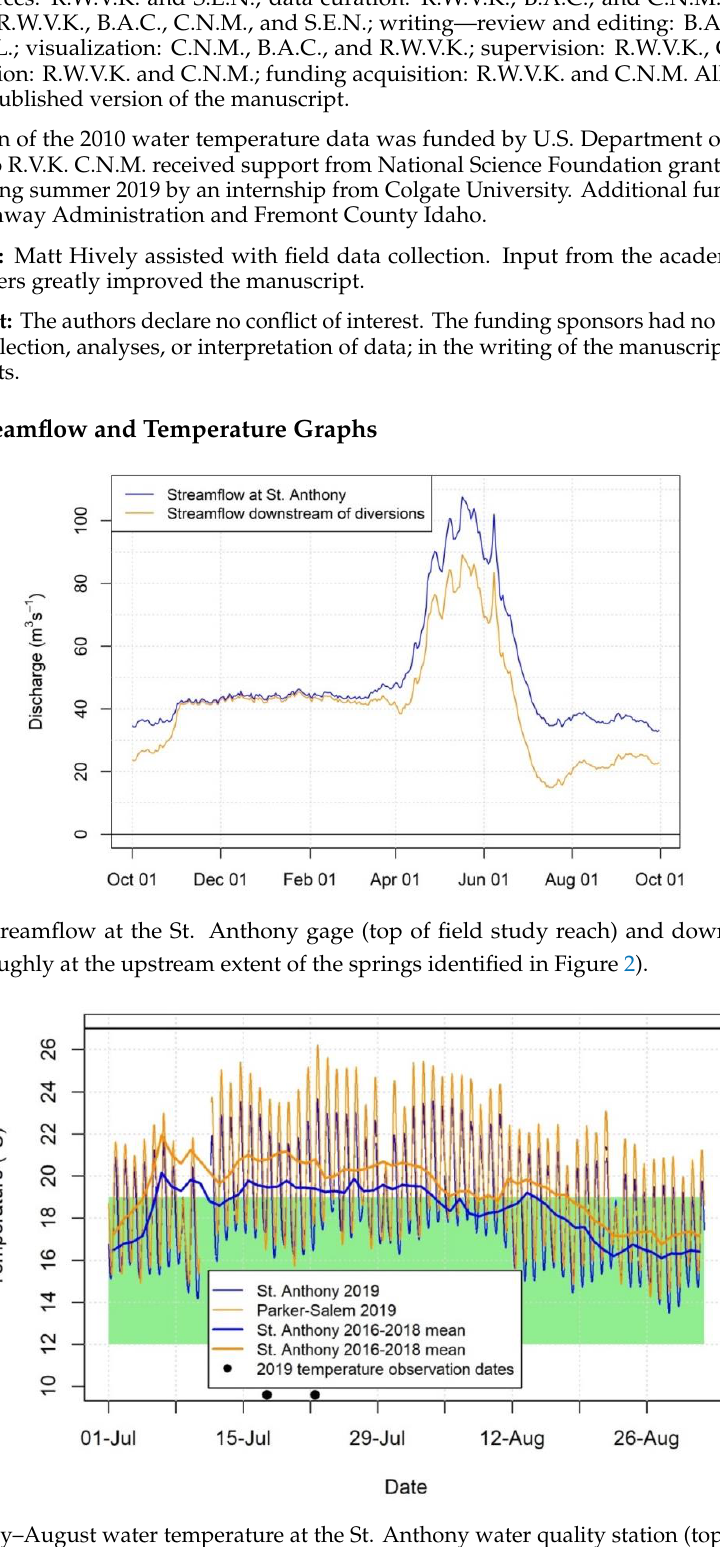
Figure A2. July – August water temperature at the St. Anthony water quality station (top of field study reach) and at the Parker-Salem water quality station (bottom of field study reach). Shaded polygon is optimal thermal range for brown trout. Horizontal line is lethal temperature limit for brown trout. The dates of the 2019 temperature observations are shown for reference.